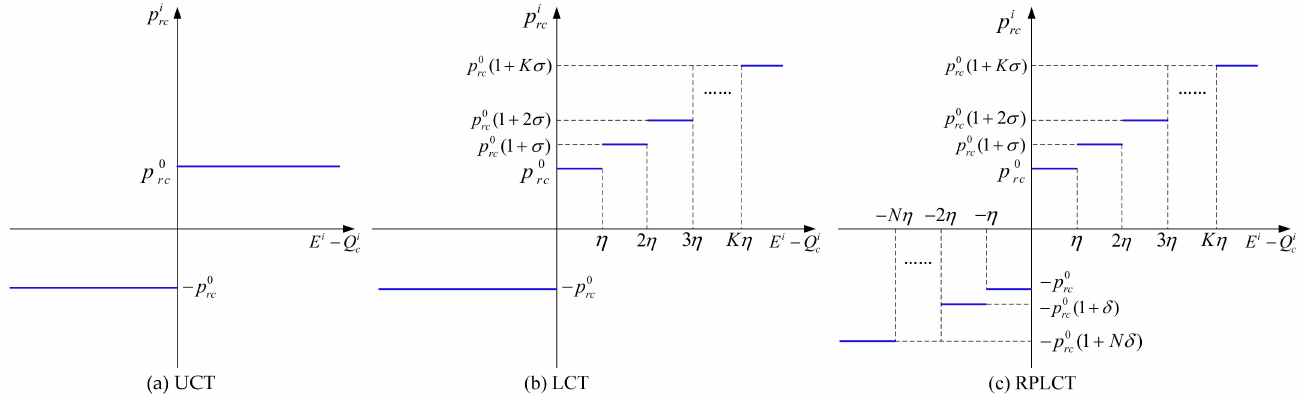
Figure 1. Carbon price for UCT, LCT and